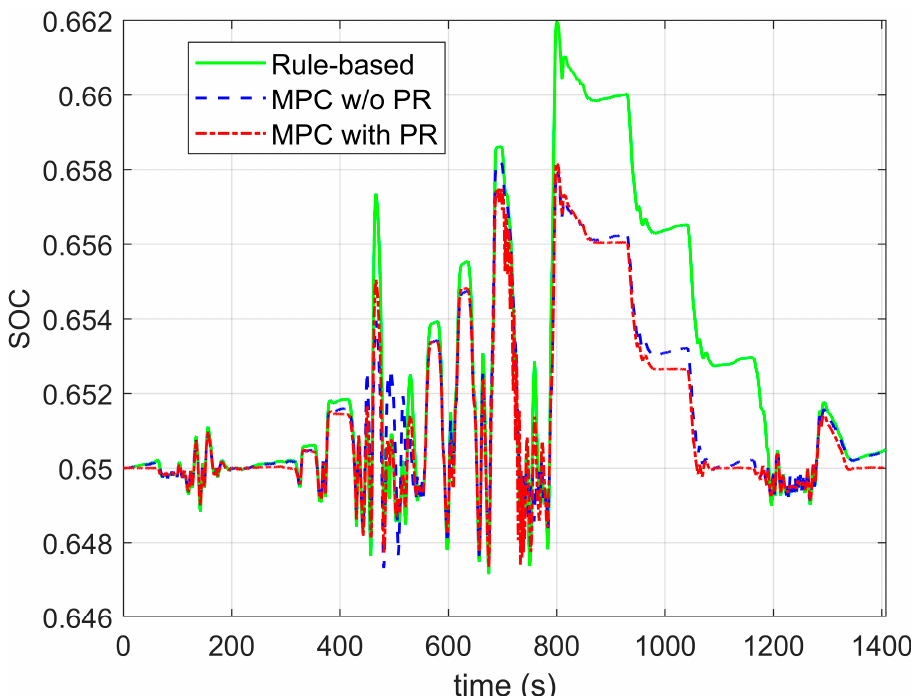
Figure 10. The SOC pro fi le.